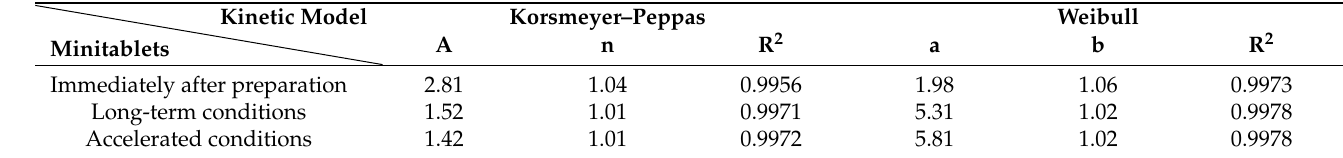
Table 4. Kinetics data calculated for minitablets analyzed immediately after preparation and after